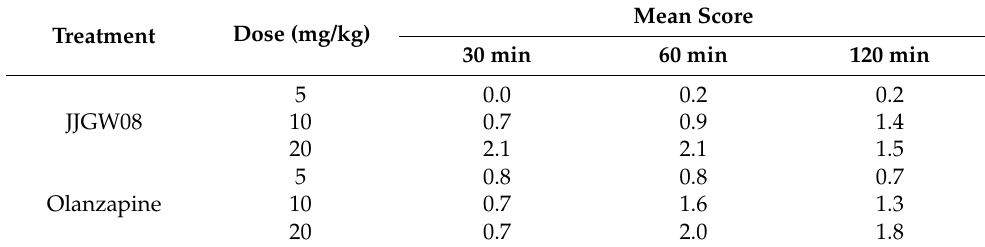
Table 2. The evaluation of cataleptogenic properties of JJGW08.